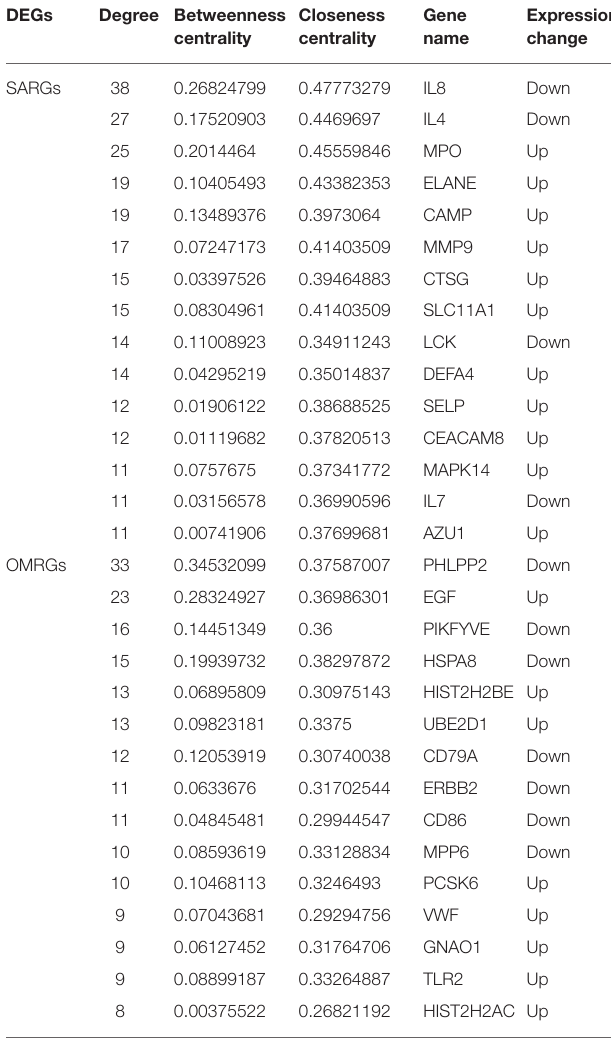
TABLE 3 | The top 15 hub proteins identified in topological analysis of the PPI network of the SARGs and OMRGs. DEGs Degree Betweenness